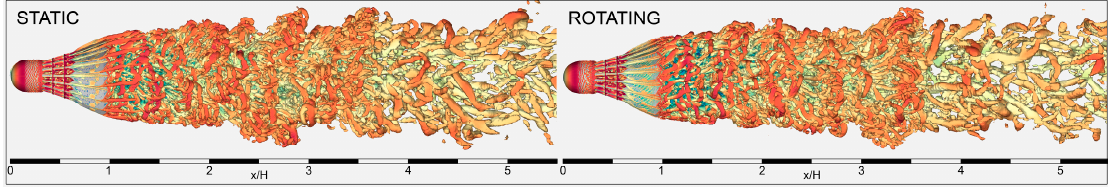
Figure 6. Visualization of vortical structures using the Q-criterion [10] method, Re = 2.7 × 10 5